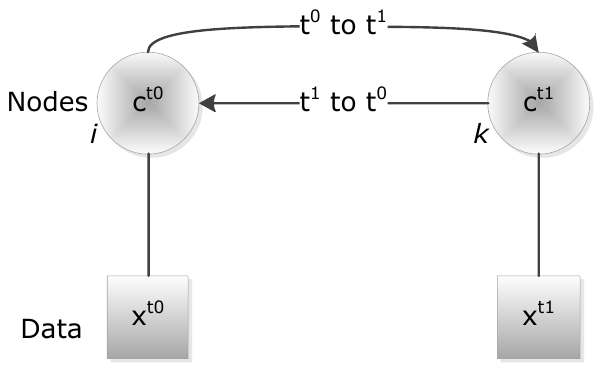
Figure 1. Designed CRF graph structure; node links are